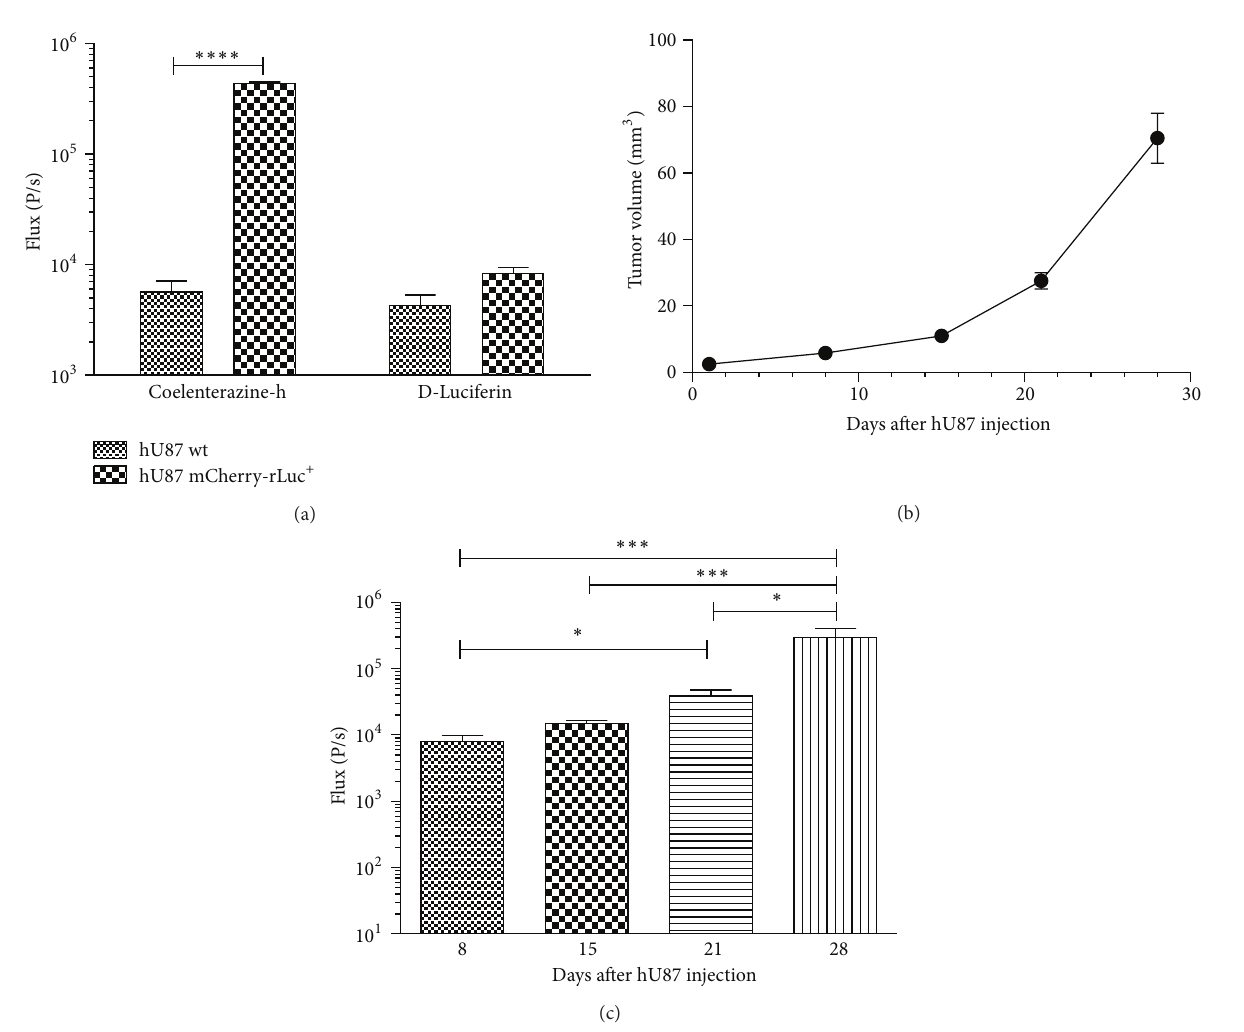
Figure 4: In vitro and in vivo validation of hU87 transduction with a mCherry-rLuc encoding vector. (a) In vitro analysis of mCherry-rLuc expressing hU87 cells showing sufficient expression of rLuc for in vitro detection by BLI using coelenterazine-h as a substrate. Furthermore, results show no statistically significant signal intensity differences after exposure of the rLuc positive hU87 cells to D-luciferin. (b) MRI- based tumor volume measurements from hU87 tumor bearing animals showed rapid growth with tumors reaching an average tumor size of 27.6 ± 2.4 mm 3 at day 21 after injection. (c) BLI measurements on mCherry-rLuc positive hU87 tumor bearing mice also indicated tumor growth over time. Levels of significance are expressed as ∗ 𝑝 < 0.05 , ∗∗ 𝑝 < 0.01 , ∗∗∗ 𝑝 < 0.001 , and ∗∗∗∗ 𝑝 < 0.0001